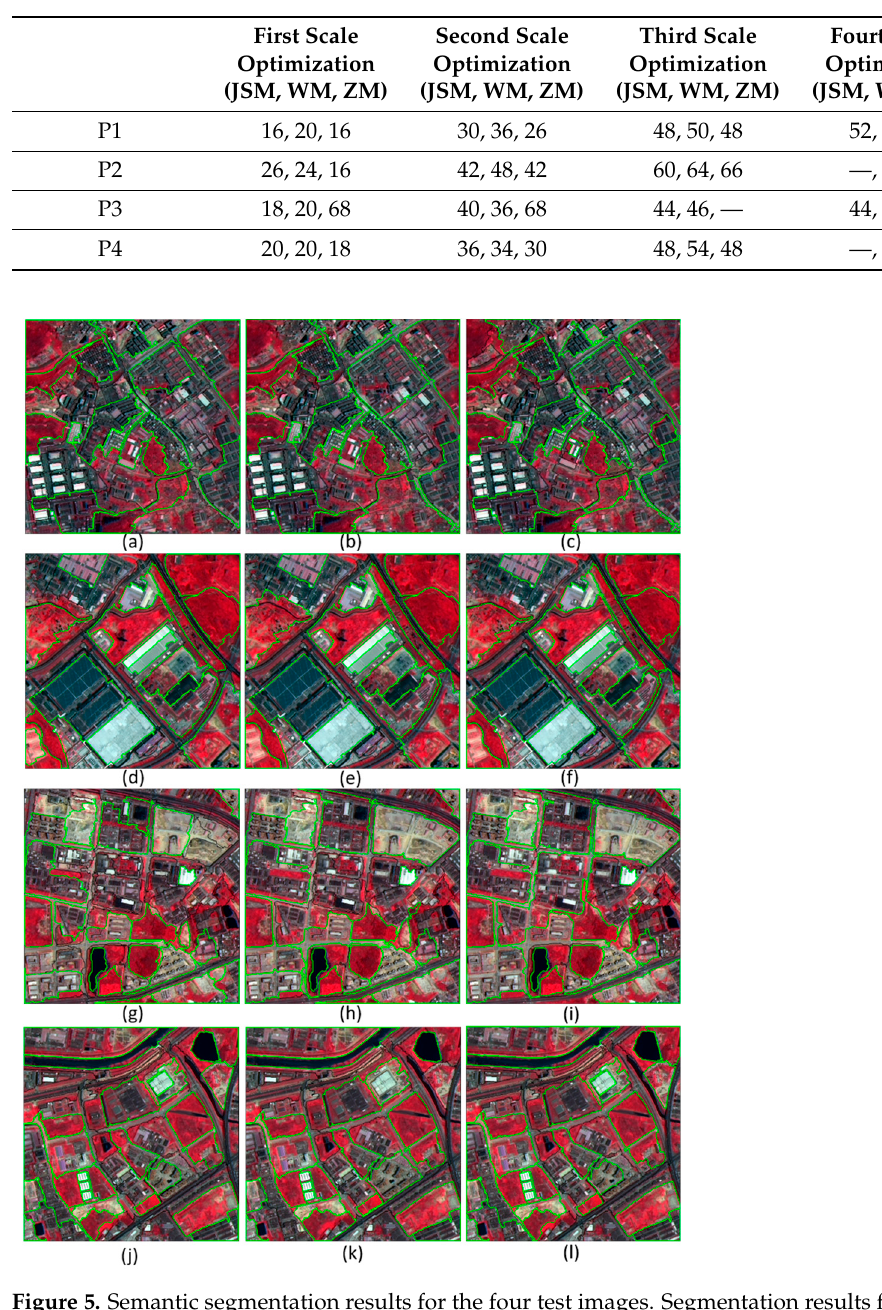
Table 4. Process of semantic scale parameter optimization.